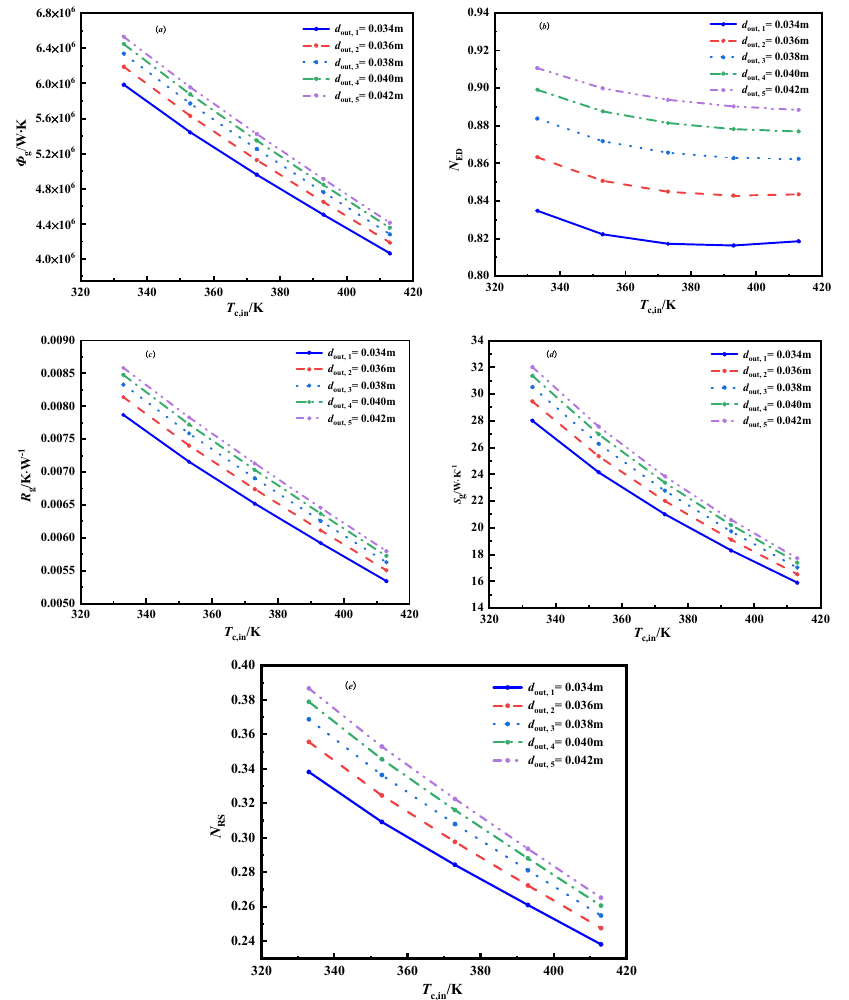
Figure 8. The 𝜙 ( a ), 𝑁 ED ( b ), 𝑅 g ( c ), 𝑆 g ( d ), and 𝑁 (cid:2902)(cid:2903) ( e ) versus the outer diameter. Figure 8. The φ g ( a ), N g ED ( b ), R g ( c ), S g ( d ), and N RS ( e ) versus the outer diameter.